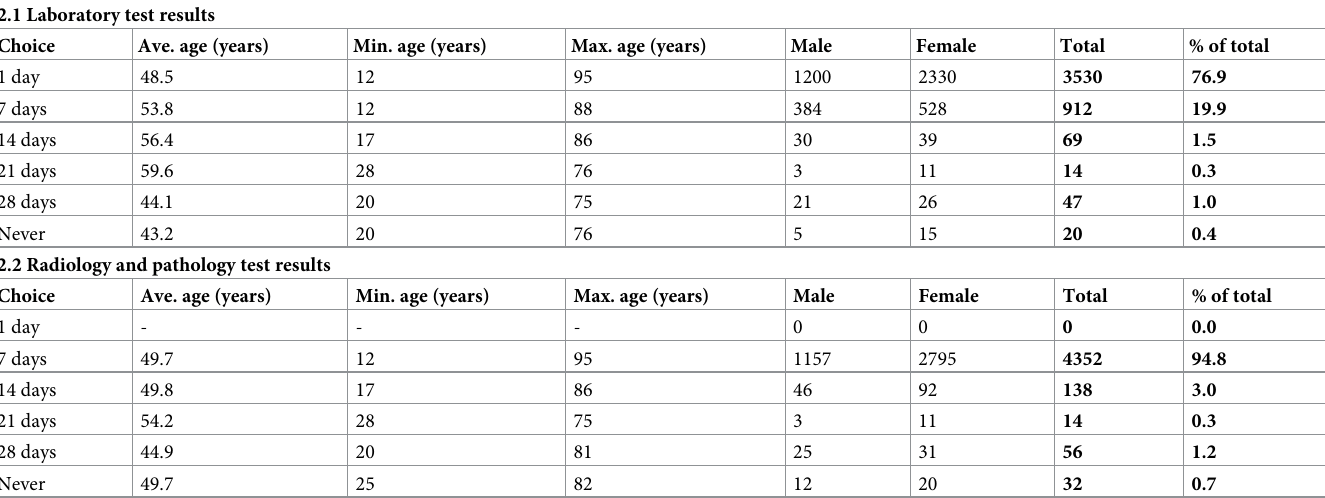
Table 2. Details of initial test result choices (N = 4592).